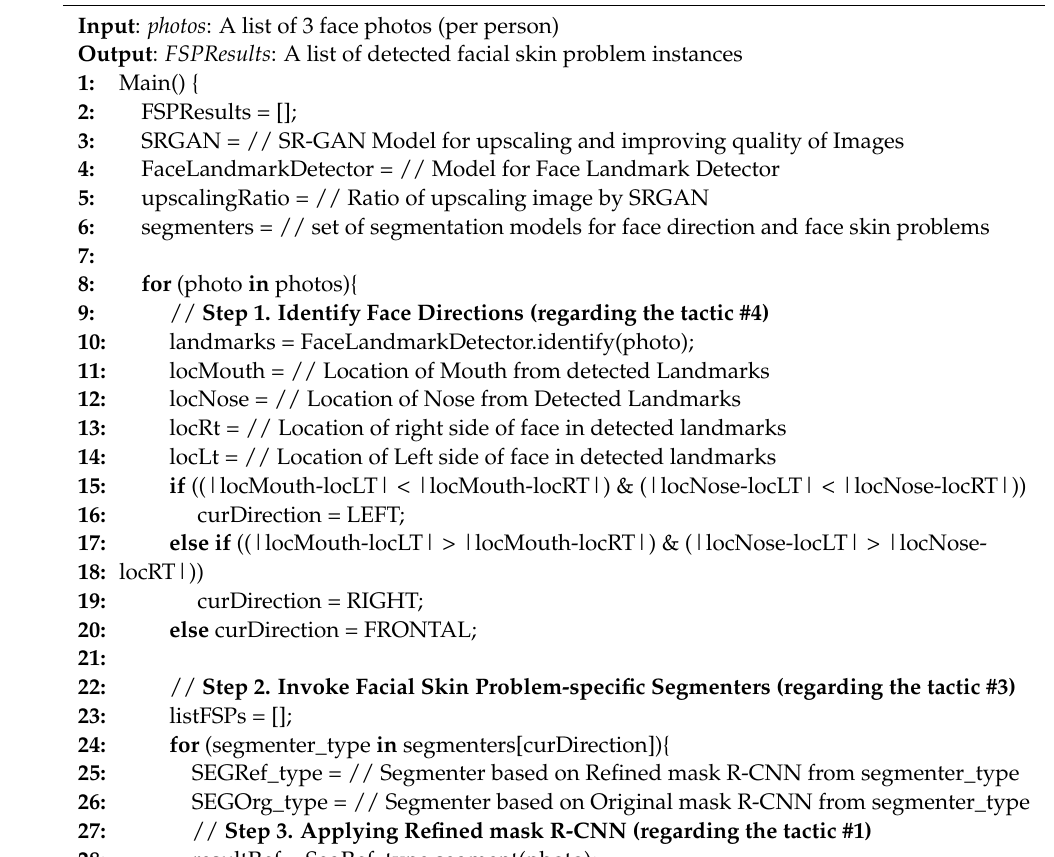
Algorithm 1 . Main control flow of ‘Facial Skin Problem Diagnosis’